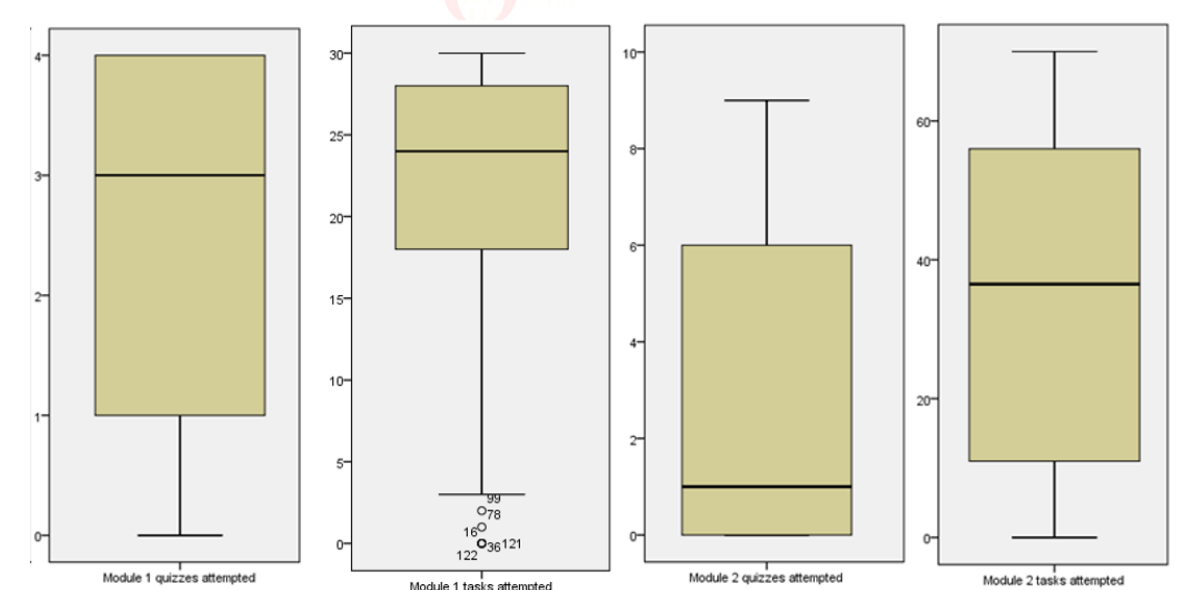
Figure 5: Boxplots showing distributions of quiz and task completions in both